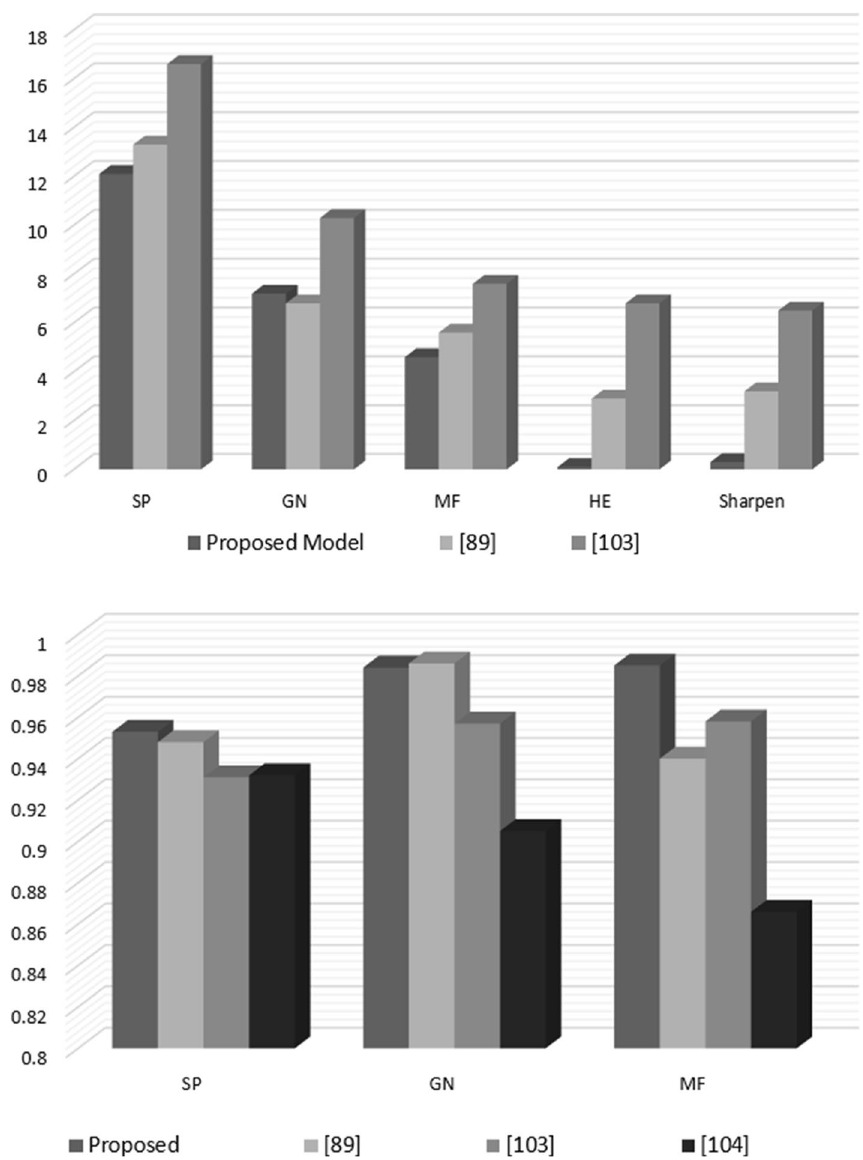
Fig. 27 The evaluation of ‘Pyramid’ image, a comparing the (Bit Error Rate) for gray scaling, b comparing the (Normalized Cross Correlation) for color scaling when it is compared to the studies in [89, 103,